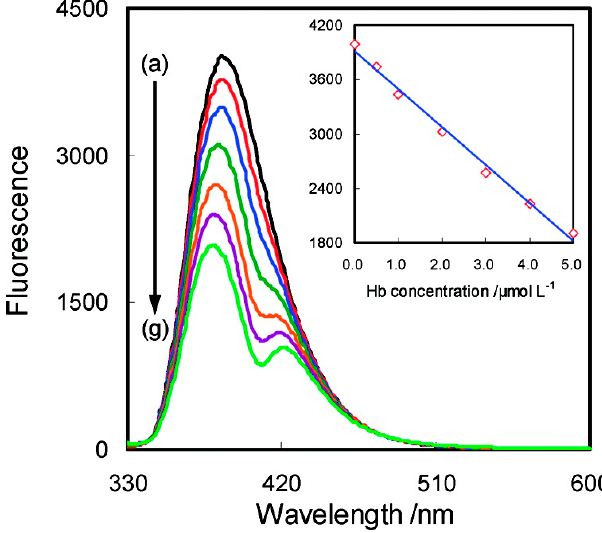
Figure 20. Fluorescence quenching of [BBim][Cl] by Hb (T = 293 K, λ ex = 315 nm). Hb concentration (µmol L − 1 ): (a) 0, (b) 0.5, (c) 1.0, (d) 2.0, (e) 3.0, (f) 4.0, (g) 5.0. [BBim][Cl] concentration in the aqueous solution: 0.01 mol L − 1 . Reprinted with permission from [207].